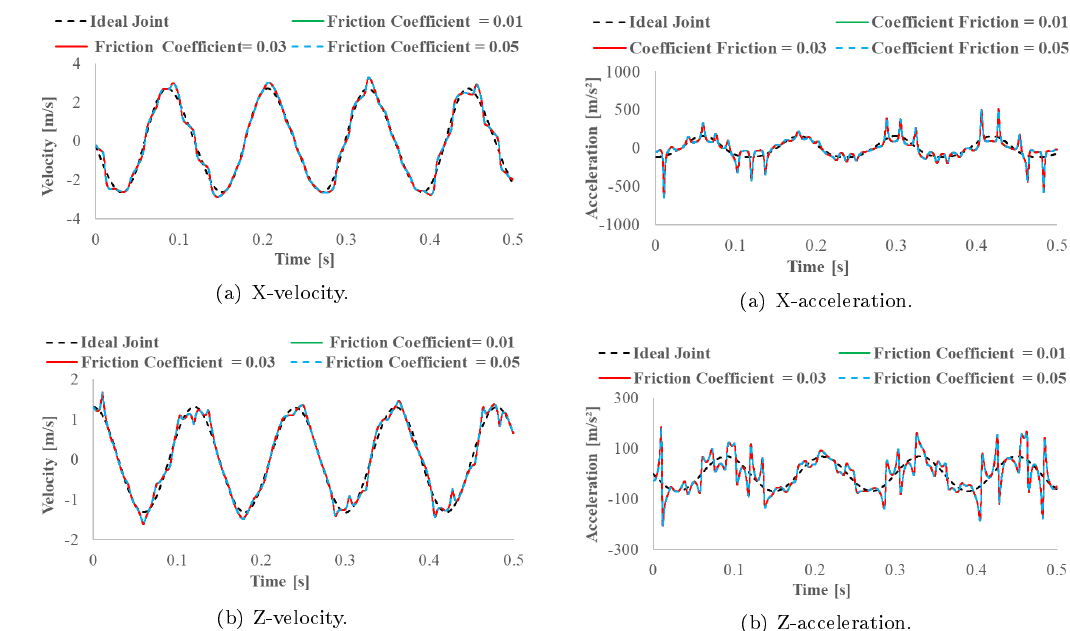
Fig. 9: Accelerations of the 1 st connecting rod .